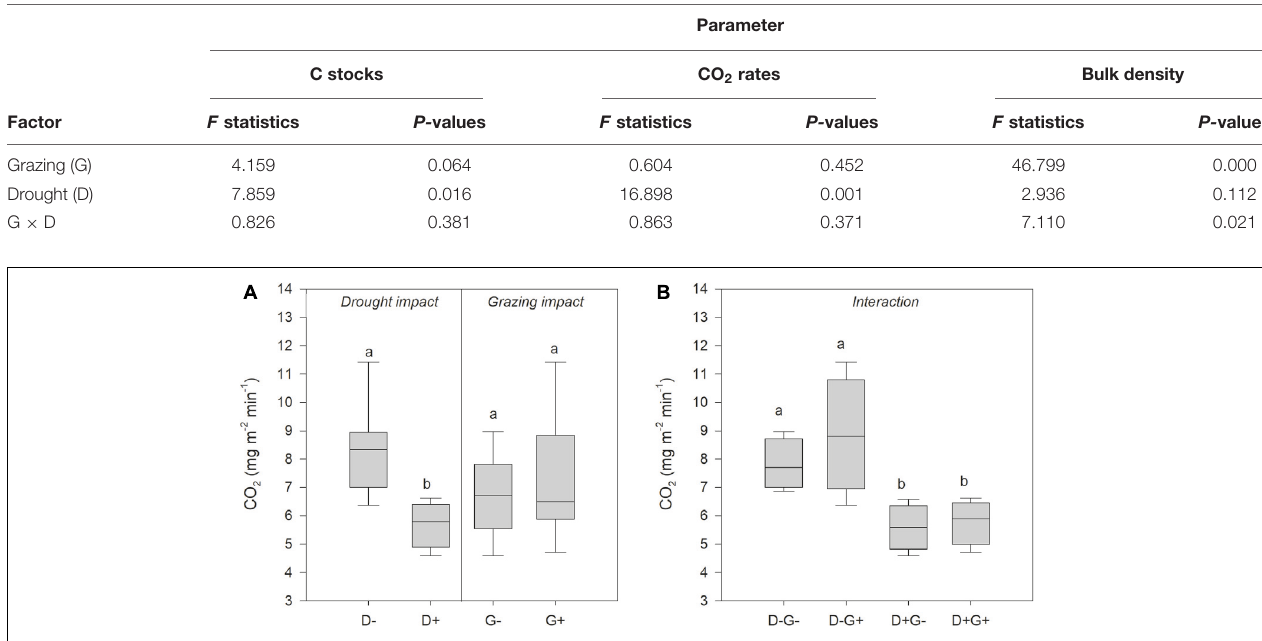
FIGURE 4 | Comparison of the effect of drought and grazing on CO 2 fluxes throughout the measurement period. (A) Impact of drought and impact of grazing; and (B) the combined effect of drought and grazing on CO 2 fluxes. Different lowercase letters indicate significant differences among treatments (P <